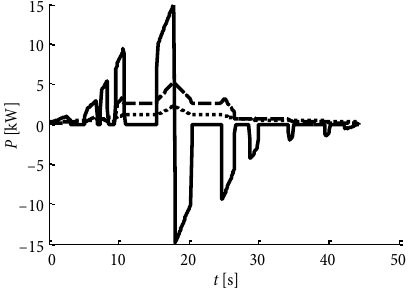
Fig. 17. Charts of traction power components: solid – accelera- tion power P K (formula (6)); dotted – aerodynamic power loss P V (formula (7)); dashed – additional power loss P D (formula